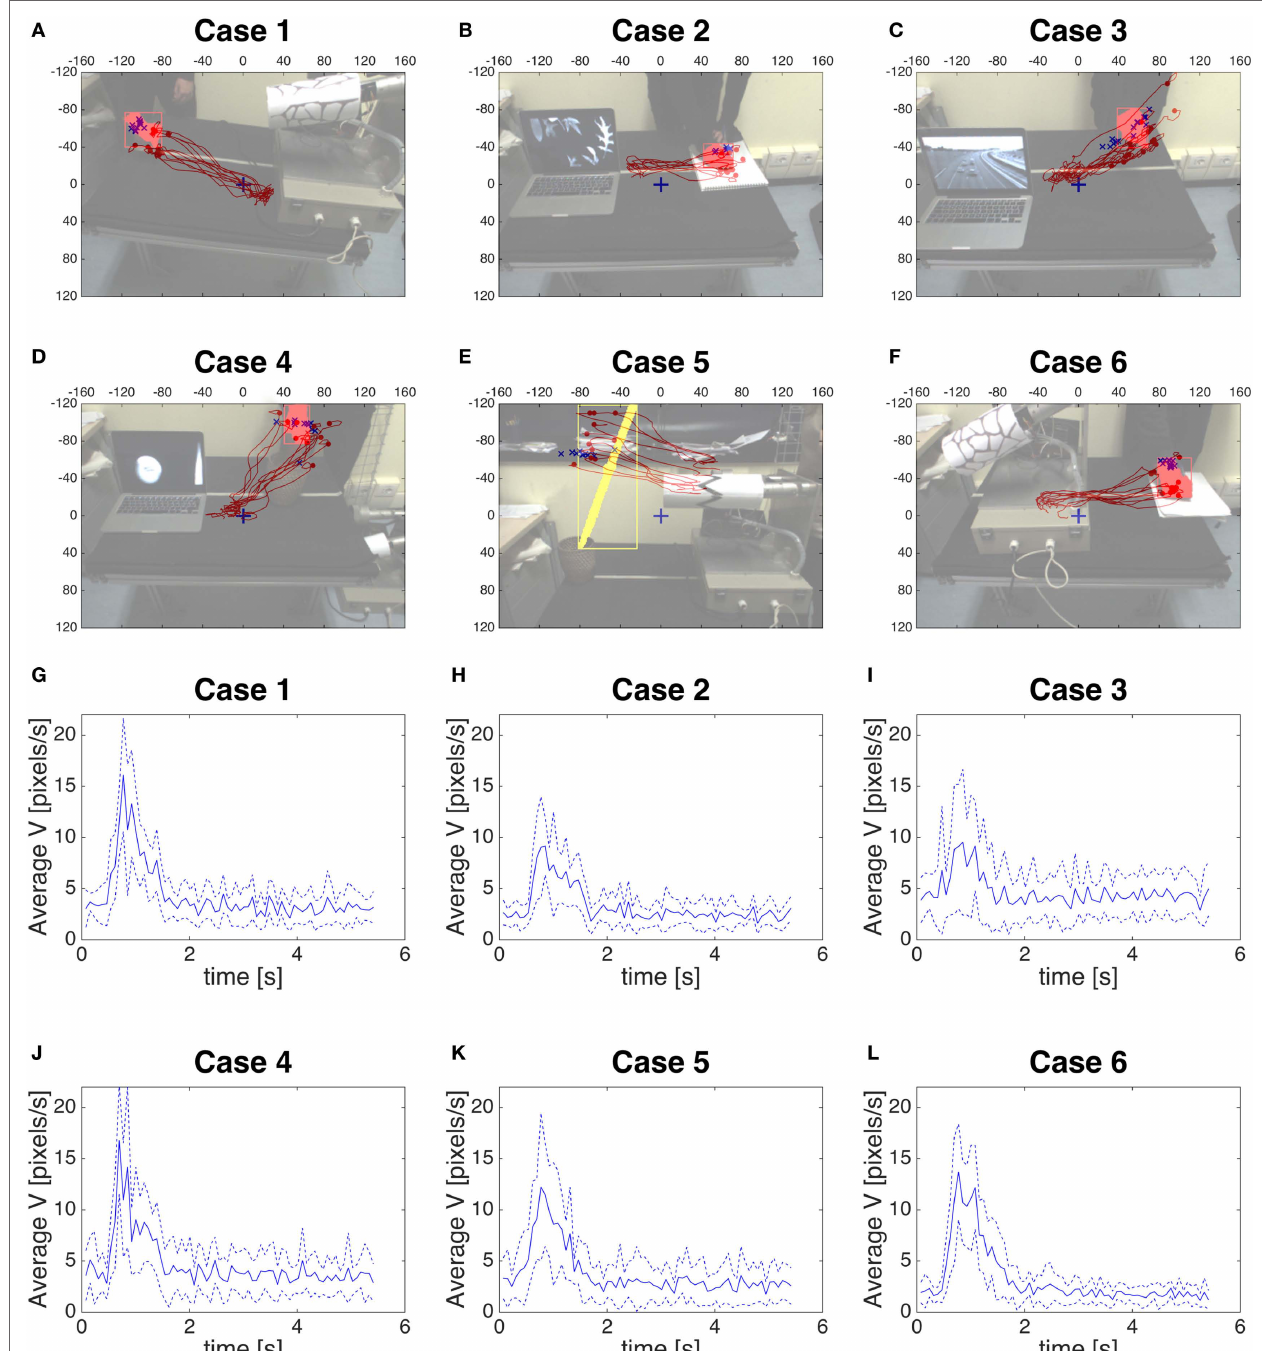
FIGURE 9 | (A–F) The position given by the color segmentation when the saccade starts (blue crosses), and the trajectory given by the saccadic commands (red line) toward the fovea (0,0). (G–L) The blue line is the average velocity of the fixation point to reach the target for each case, the blue dotted line is the average velocity (cid:6)